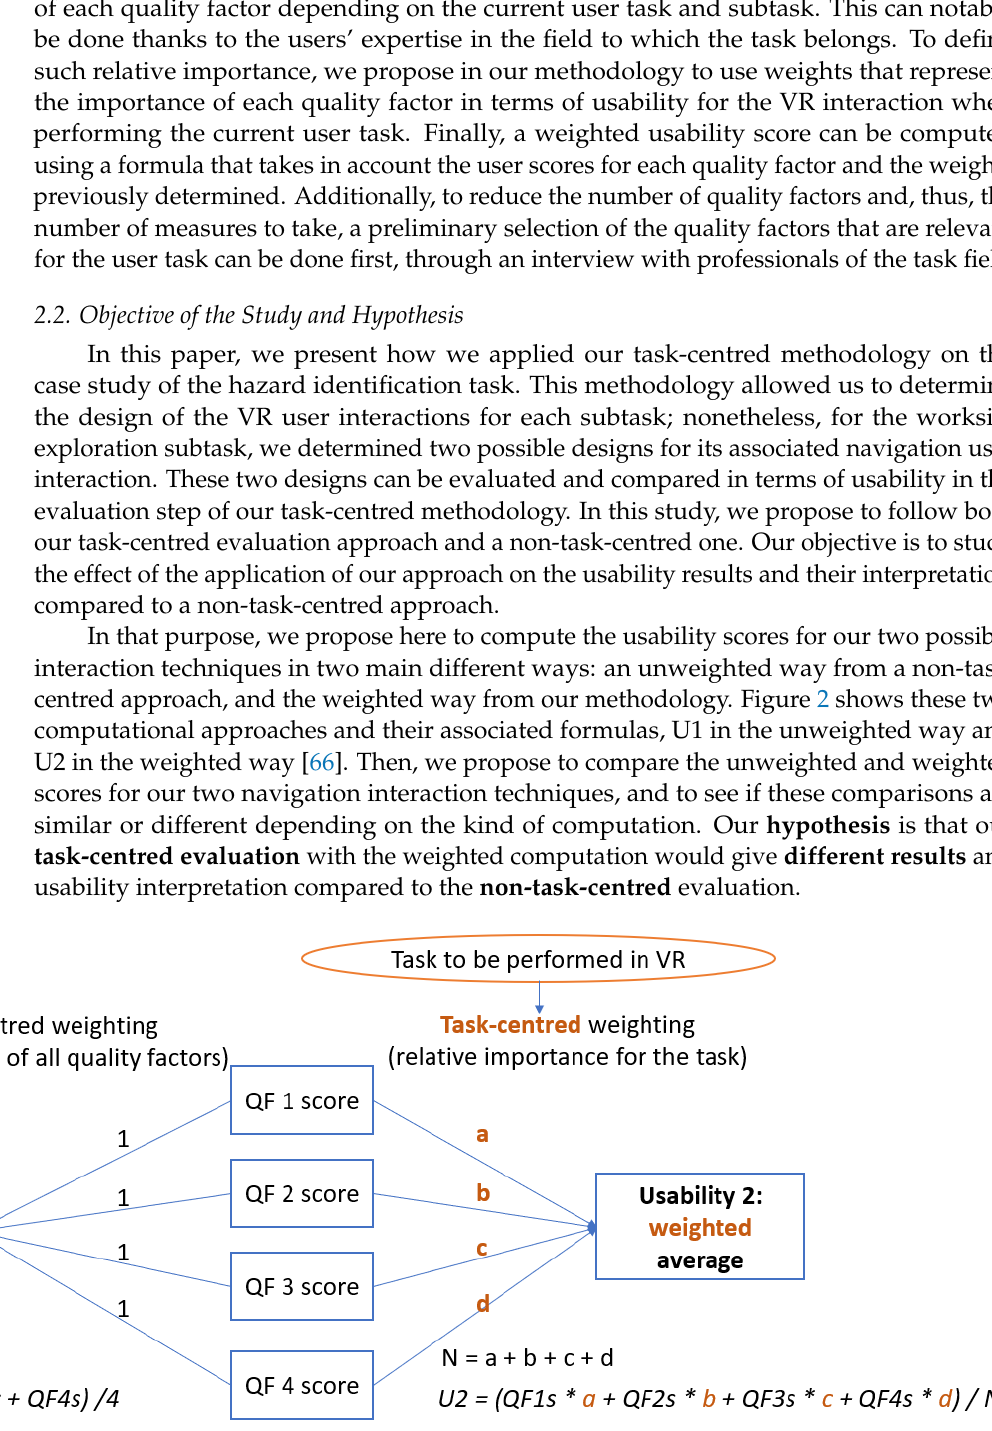
Figure 2. Quality factors and usability scores computation: average versus weighted